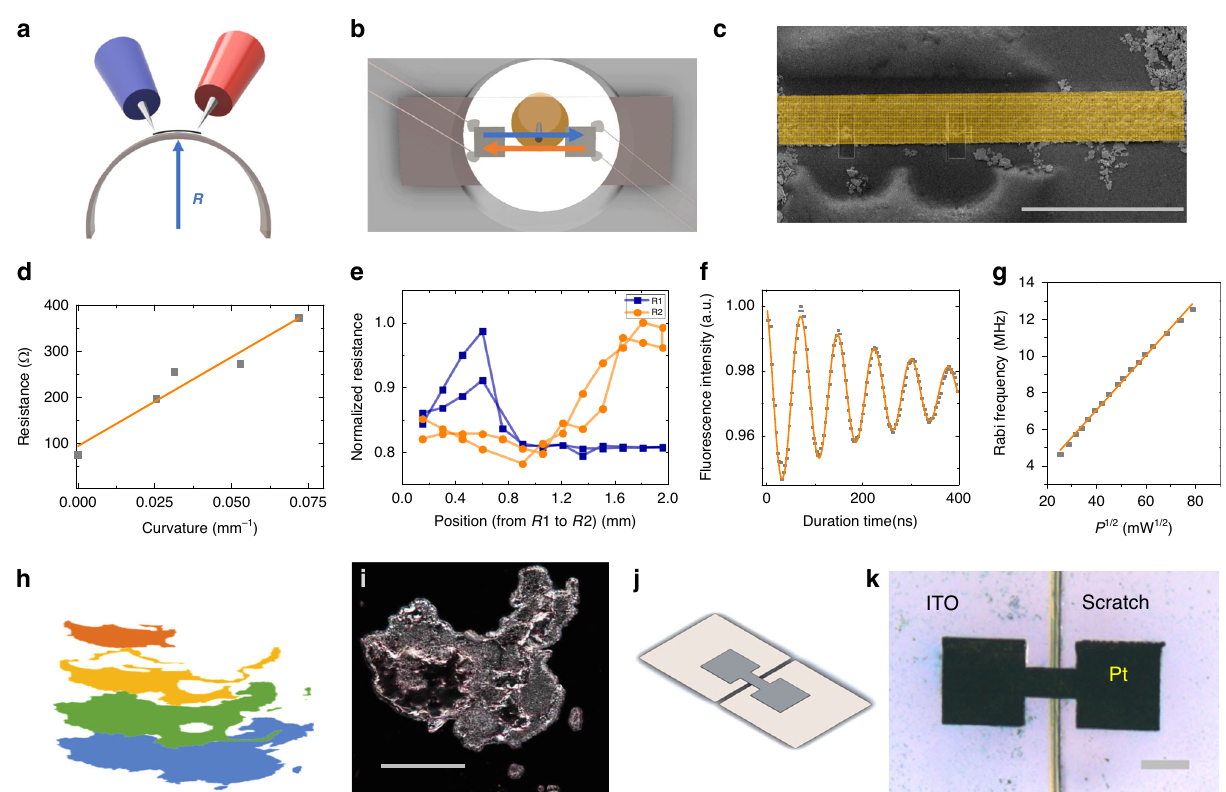
Fig. 4 Devices made by the LIMD method for practical applications. a – b schematic illustrations of two fl exible devices: a resistive fl ex sensor a and a resistance-based touch sensor b (more details in Supplementary Information). c the SEM image of the microwave waveguide coupled with nanodiamond particles. d resistance dependence with curvature measured in the device in a . e resistance dependence of two platinum squares in the device b with position of touching. The resistance is normalised to the values without touching. f the microwave driven Rabi oscillation of electron spins in NV centres in diamond in the vicinity of the waveguide in c . g the microwave power dependence of the Rabi oscillation frequency. The microwave power was measured after the microwave power ampli fi er before entering the microwave waveguide. h design patterns for 3D laser writing. The structure was written in the layer by layer manner. The raw topography data were obtained from the Ministry of Natural Resources of China. i a 3D topographic map made by the iron oxide deposition. j , k the schematic design j and the microscopic image k of repairing the gap between ITO contacts with the LIMD method. The grey scale bars represent 100 μ